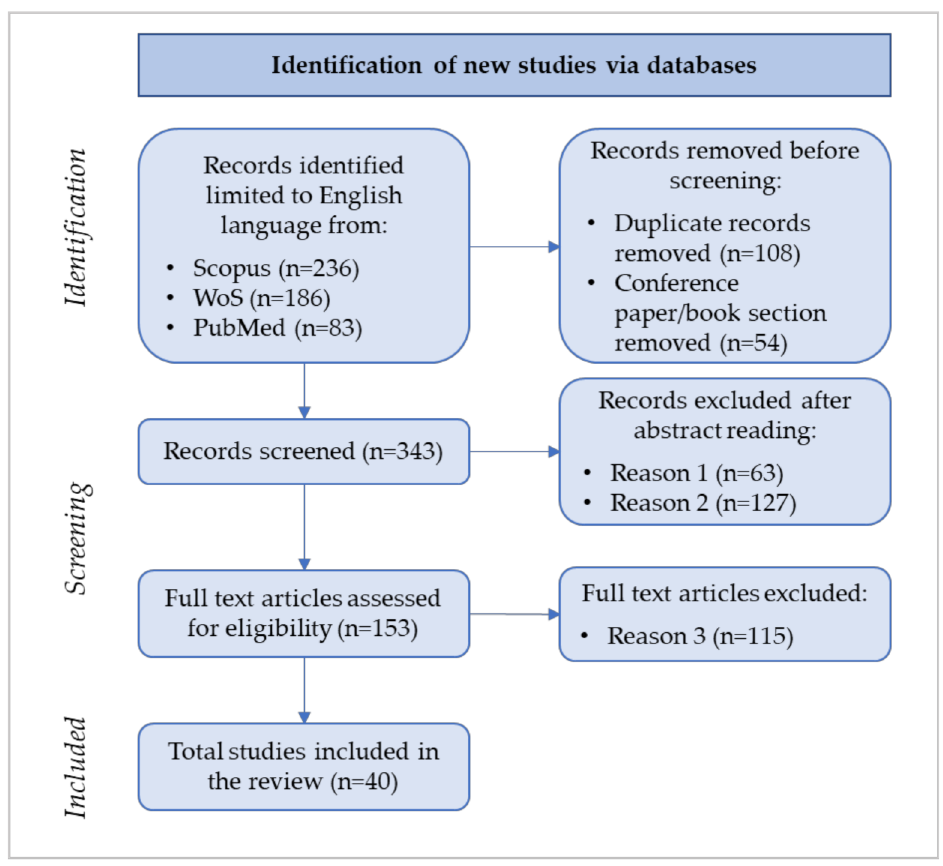
Figure 1. Flow diagram of the